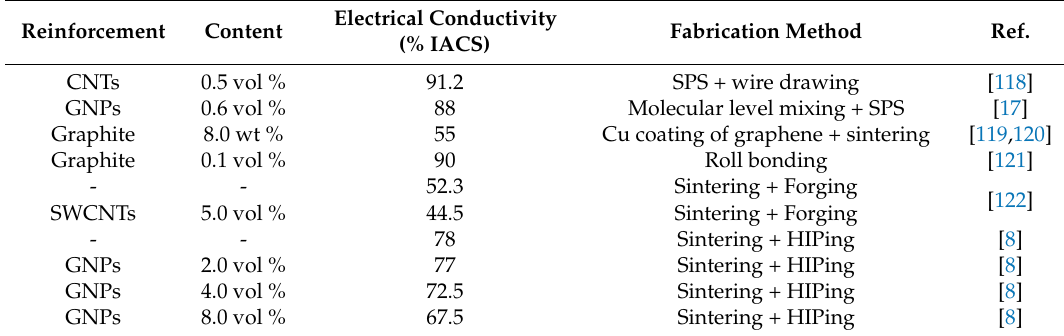
Table 6. A summary of the electrical conductivity of copper composites reinforced with different types and vol % of reinforcements. SPS, spark plasma